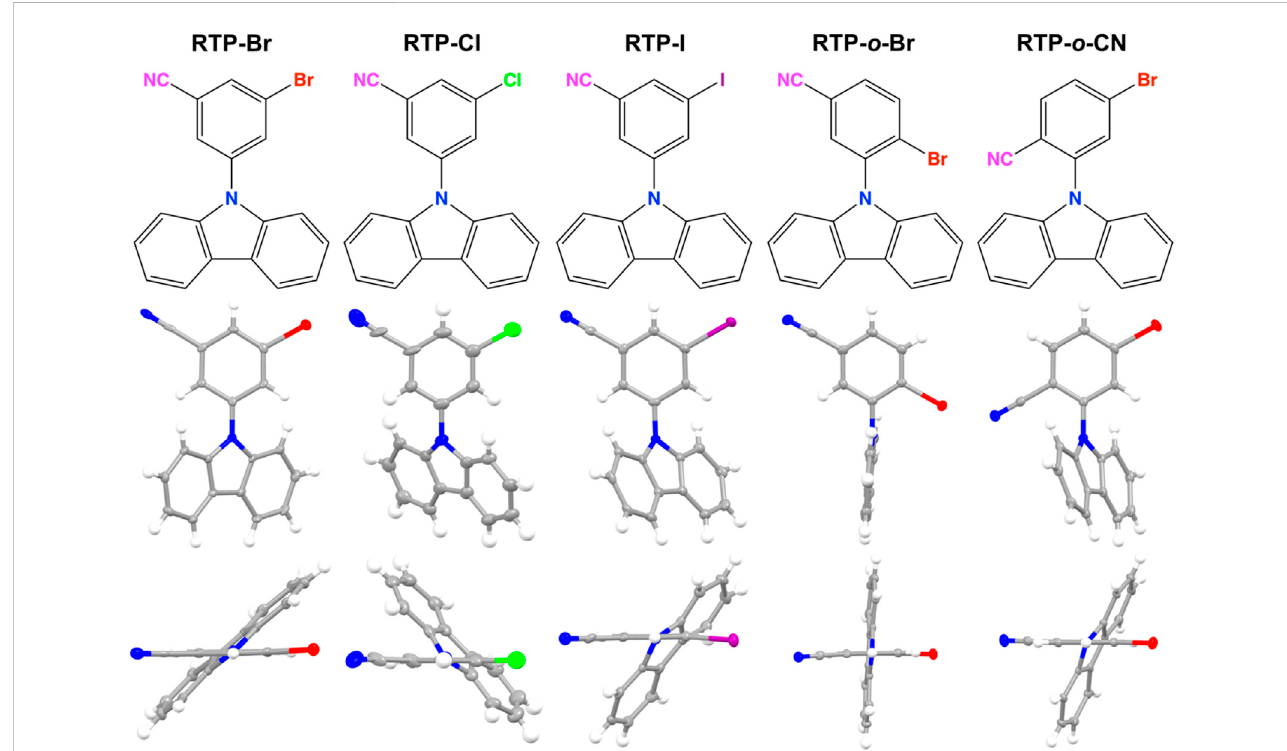
FIGURE 1 Molecular structures andsingle-crystal X-ray crystal structures ofthepRTP materials RTP-Br , RTP-Cl , RTP-I , RTP- o -Br ,and RTP- o -CN (left to rightwith front and side views).